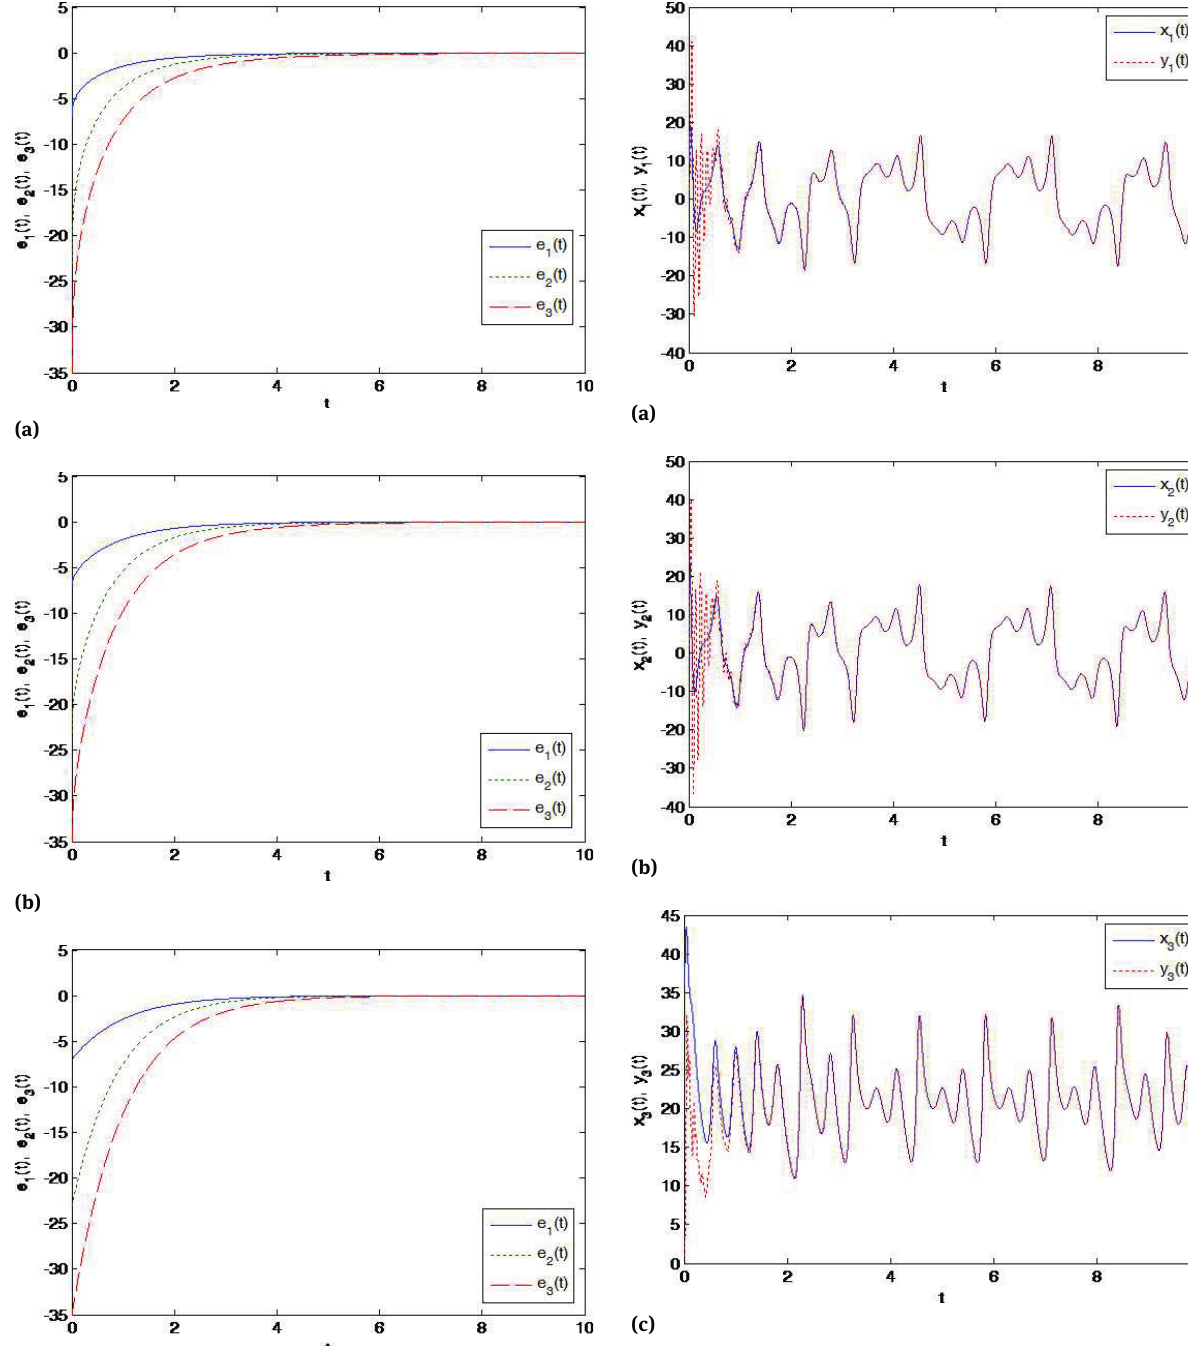
Fig. 5: State trajectories of drive system (1) and response system (3) for fractional order q = 0.96 : (a) between x 1 and y 1 , (b) between x 2 and y 2 , (c) between x 3 and y 3 using backstepping